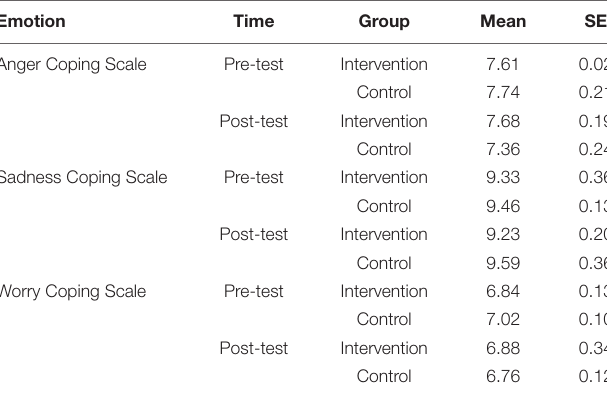
TABLE 3 | Descriptive statistics by emotion and group, over